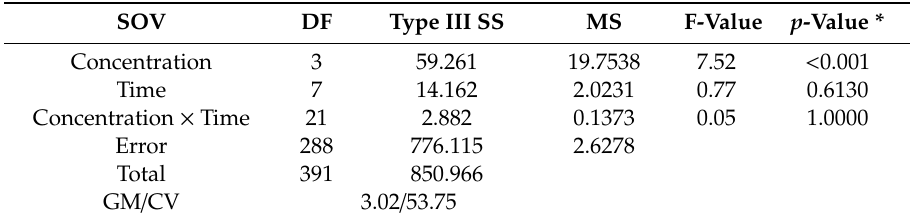
Table 2. Univariate analysis of variance table for the effect of partially purified protein purified of Beauveria bassiana (ARSEF 2860) on the fecundity rate of B. tabaci (cf. Figure 3). SOV DF Type III SS MS F-Value